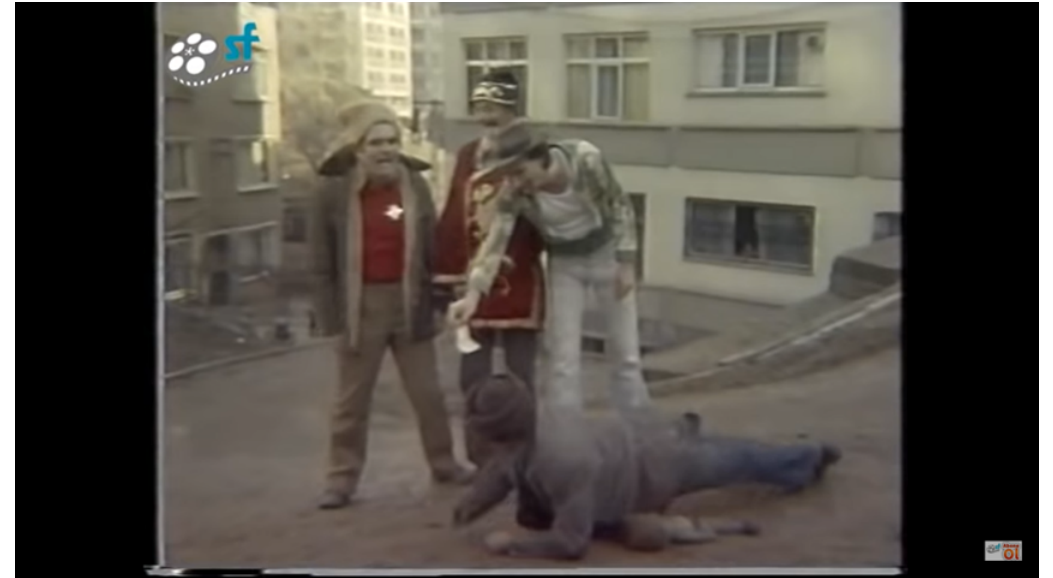
Figure 6- Russian, Chinese, and American nations insulting the